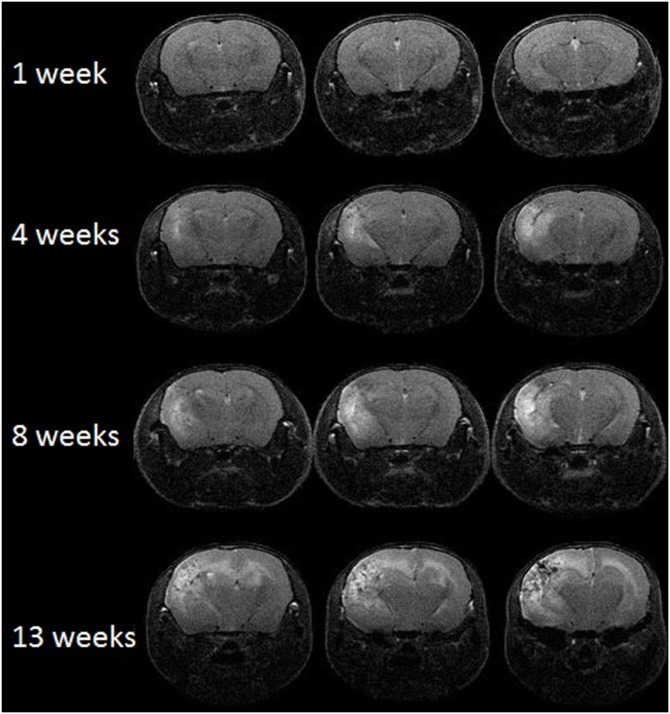
MRI can monitor radiation necrosis in irradiated mouse brain.Representative contrast-enhanced, transaxial T2-weighted spin-echo images of irradiated mice at 1, 4, 8, and 13 weeks following a single 50-Gy (50% isodose) of radiation. Slices are chosen to display the same anatomic region of the brain at all four time points.